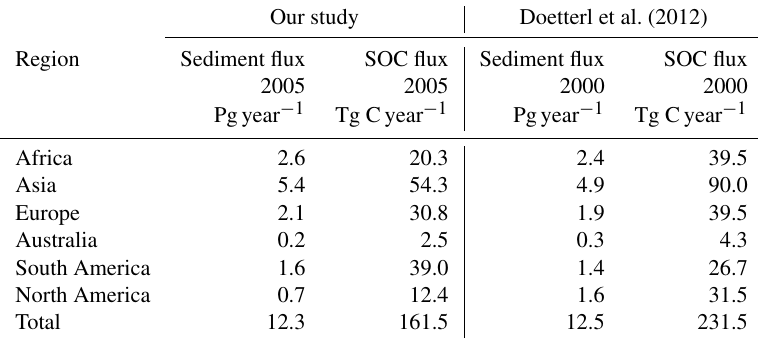
Table 7. Comparison of our model best estimates of agricultural soil erosion and SOC erosion rates for the year 2005 with best model/observation estimates from Doetterl et al. (2012) per continent. The uncertainty range for the present-day sediment and SOC fluxes is 18%–62% and 5%–51%, respectively. The uncertainty range in the values of Doetterl et al. (2012) is 30%–70%. Our